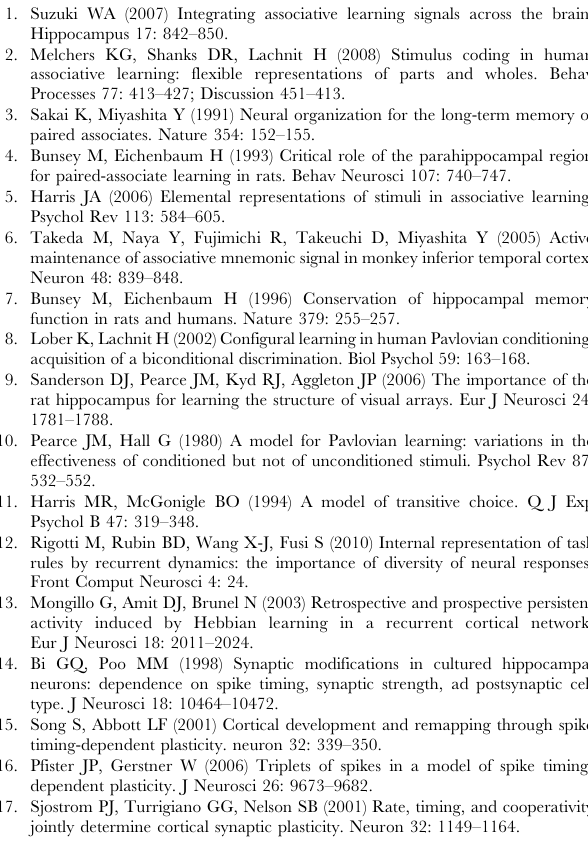
Figure S10 Network decision-making performance - Varying the voltage threshold for induction of LTPi. Each matrix contains the results for 25 networks trained with LTPi alone with varying postsynaptic voltage thresholds for the induction of LTPi, with 5 levels of input correlation (x-axis) and 5 levels of sparseness (y-axis) in one of six conditions: A. LTPi with no voltage dependence